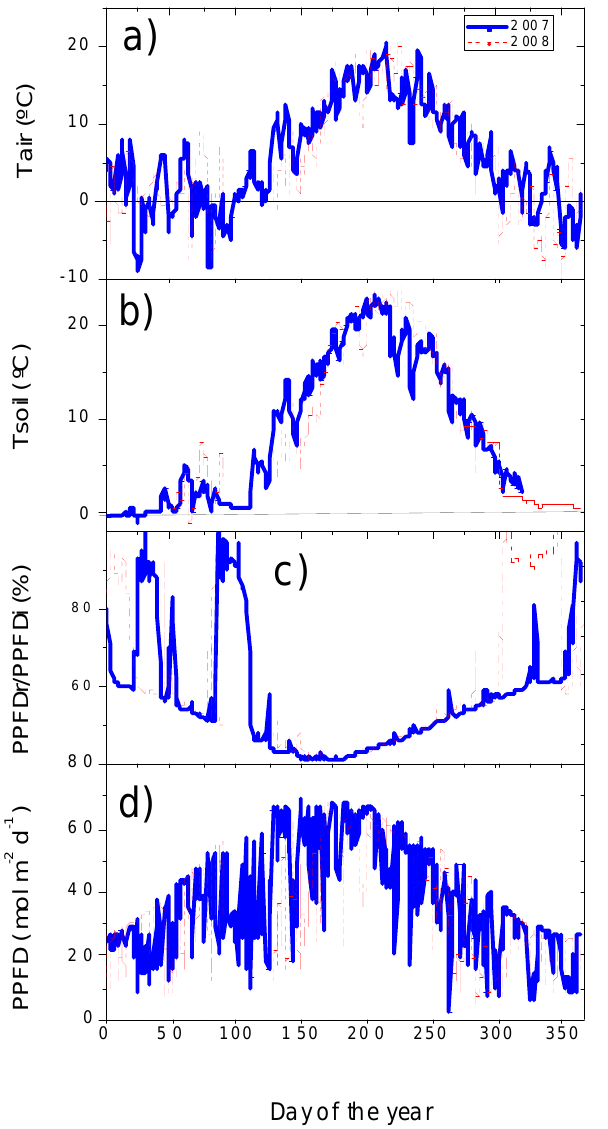
Fig. 1. Average daily environmental conditions in the alpine